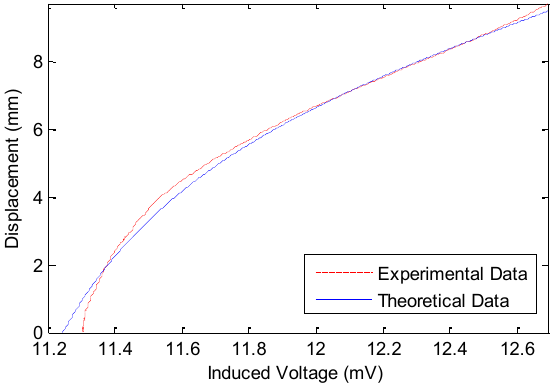
Figure 7. The slope of the curve in Figure